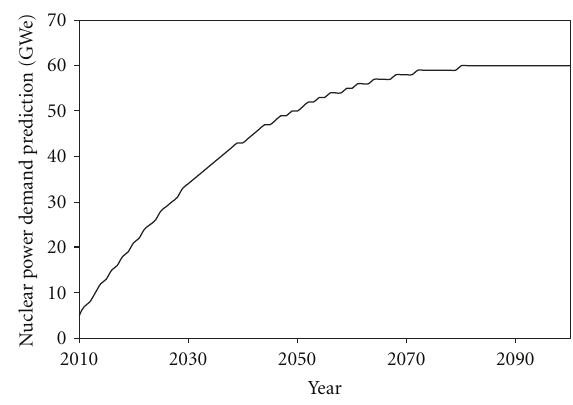
∗ SWU stands for separative work unit.